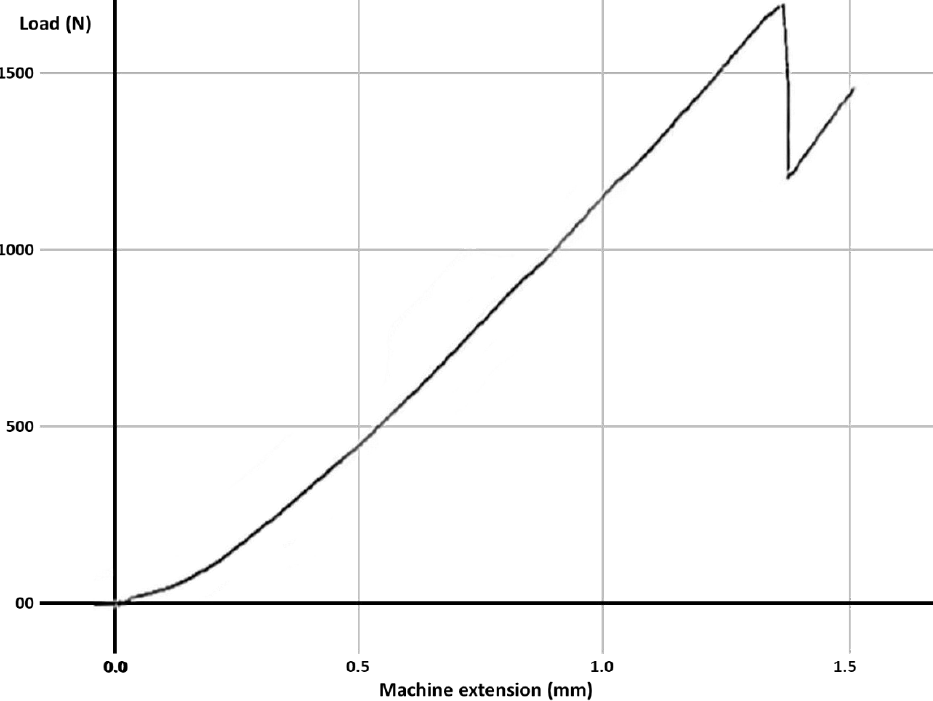
Figure 6. The maximum value of the force at which the most resistant molar from Group E failed.